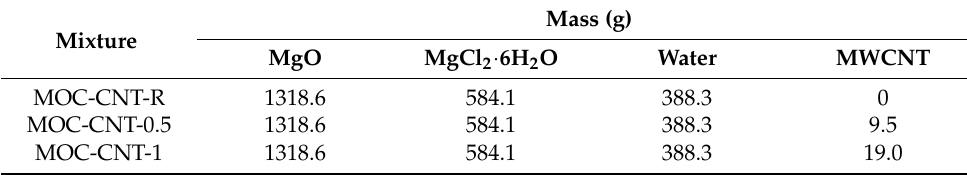
Table 1. Mix proportions of composites